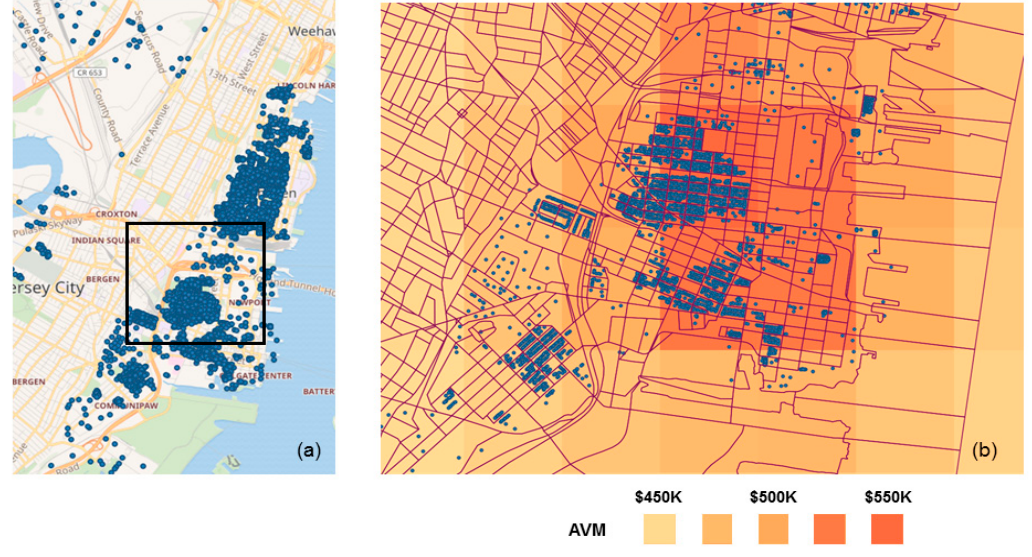
Figure 2. ( a ) denotes the spatial distribution of properties (spatial points) on small area of Hudson county; the polygons in the right-hand panel ( b ) represent Census blocks and the underlying color scheme indicates the outcome of inverse distance weighting (IDW) spatial interpolation process in predicting the automated valuation model (AVM) values.